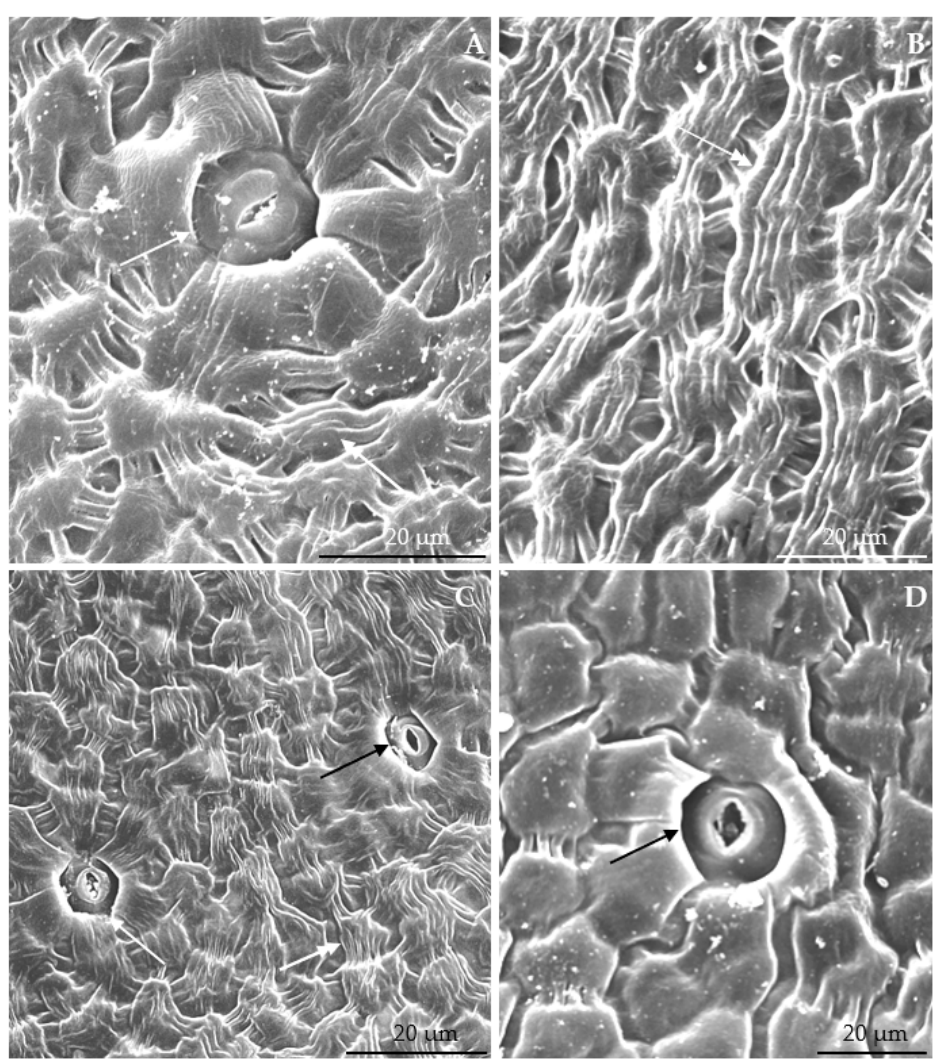
Figure 8. ( A – D ). Fragments of the nectary epidermis surface in the initial secretion phase in R. idaeus ‘Polana’ ( A , B ) and ‘Polka’ ( C , D ). ( A ): semi-open stomata located at the level of other epidermis cells (arrow); visible smooth cuticle surface on the stomatal cells, cuticular striae arranged next to each other, sometimes slightly bent (double-headed arrow). ( B ): cuticular stria bands (double-headed arrow) along the longer axis of epidermis cells. ( C ): open stomata (arrow); cuticle bands with multidirectional arrangement near the stomata ( D ) (double-headed arrow). Table 2. Characteristics of selected traits of cuticle ornamentation on the surface of nectary epidermis cells in the full nectar secretion phase in the R. idaeus cultivars ( µ